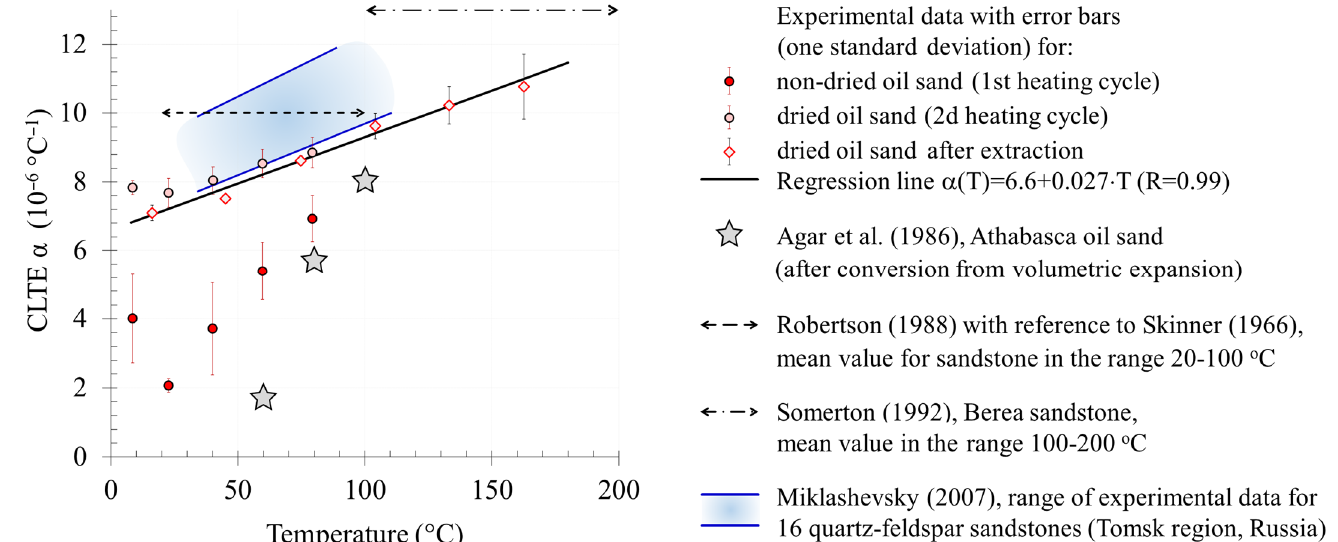
Figure 9. CLTE depending on the temperature of the studied samples from the Karabikulovskoye field after extraction and in non-extracted state (during the first and second heating cycles) and comparison with previously published data (see comments in the text).